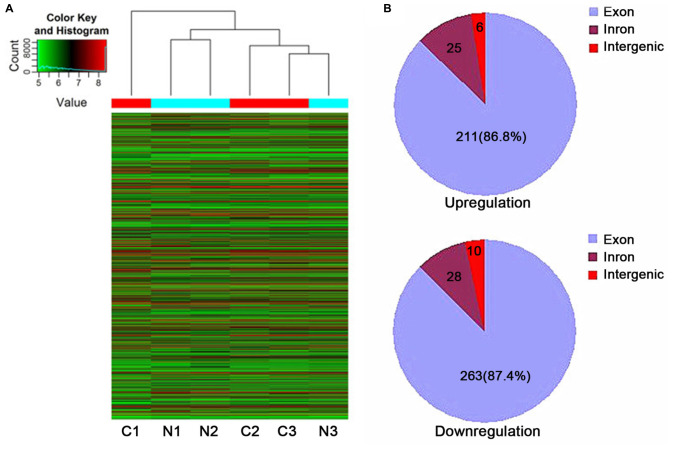
Characterization of circRNA expression in GISTs. (A) Hierarchical cluster map. (B) The origin of upregulated and downregulated circRNAs. N, adjacent normal tissues; C, GIST tissues.